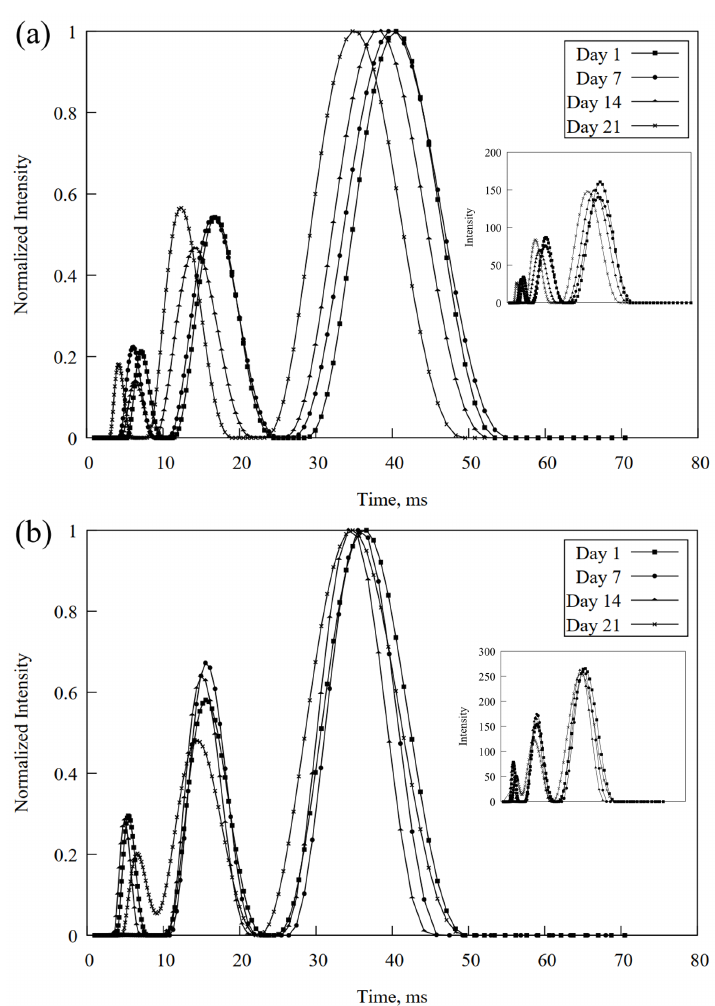
Figure 5. Oil relaxation time distribution (T 2 ) in a glass beads pack saturated to 100% with oil: ( a ) Untreated glass beads aged for 21 days at 25 ◦ C; ( b ) Treated glass beads aged for 21 days at 25 ◦